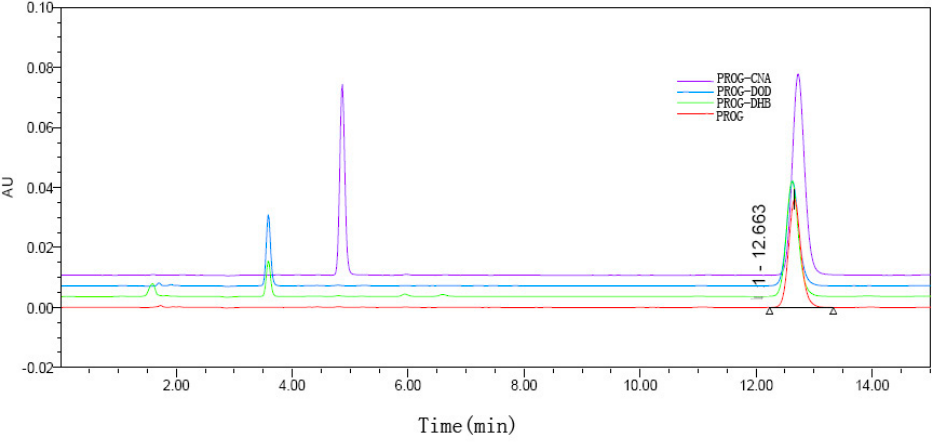
Figure 8. In vitro powder dissolution profile of PROG and the co-crystals at 37 °C .